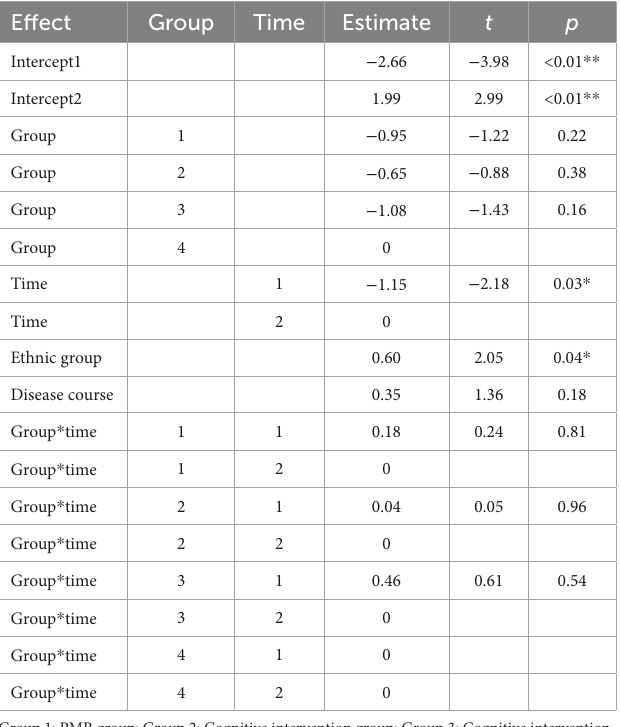
TABLE 5 Fixed effects of remission results ( n = 165).